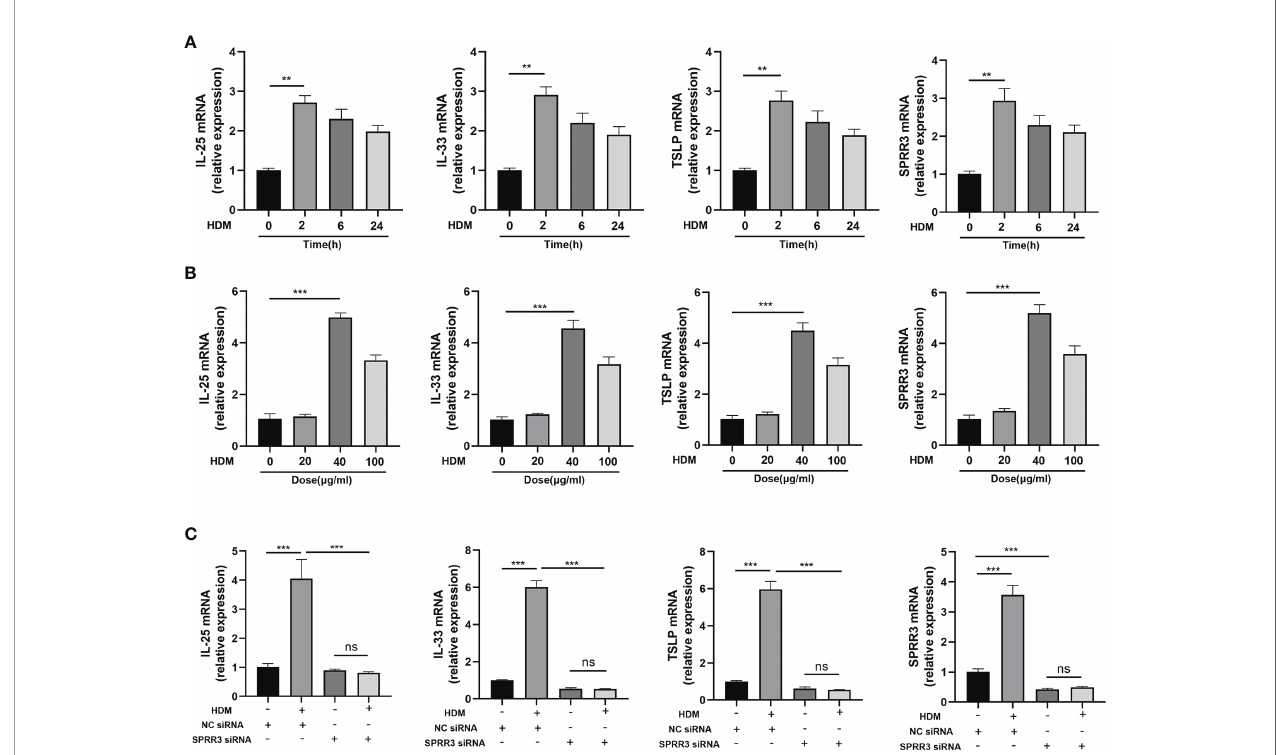
FIGURE 5 | SPRR3 contributes to the upregulation of alarmins IL-25, IL-33, and thymic stromal lymphopoietin (TSLP) after exposure to allergens in vitro . (A) mRNA expressions of IL-25, IL-33, TSLP, and SPRR3 in BEAS-2B cells at different times after exposure to house dust mite (HDM) (40 m g/ml). (B) mRNA expressions of IL-25, IL-33, TSLP, and SPRR3 in BEAS-2B cells exposed to different concentrations of HDM. (C) mRNA expressions of IL-25, IL-33, TSLP, and SPRR3 in BEAS- 2B cells after transfection with SPRR3 siRNA or negative control siRNA prior to HDM exposure. Values represent mean ± SEM, n = 3 independent experiments. ** p < 0.01, *** p < 0.001. ns, no signi fi cant